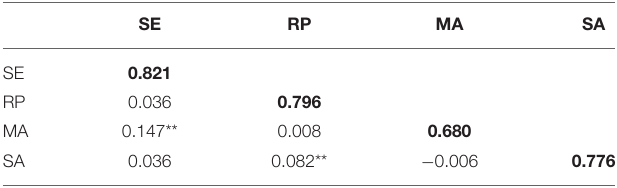
TABLE 2 | Reliability and validity analysis ( N = 1511). TABLE 3 | Correlation and coefficient matrix ( N =